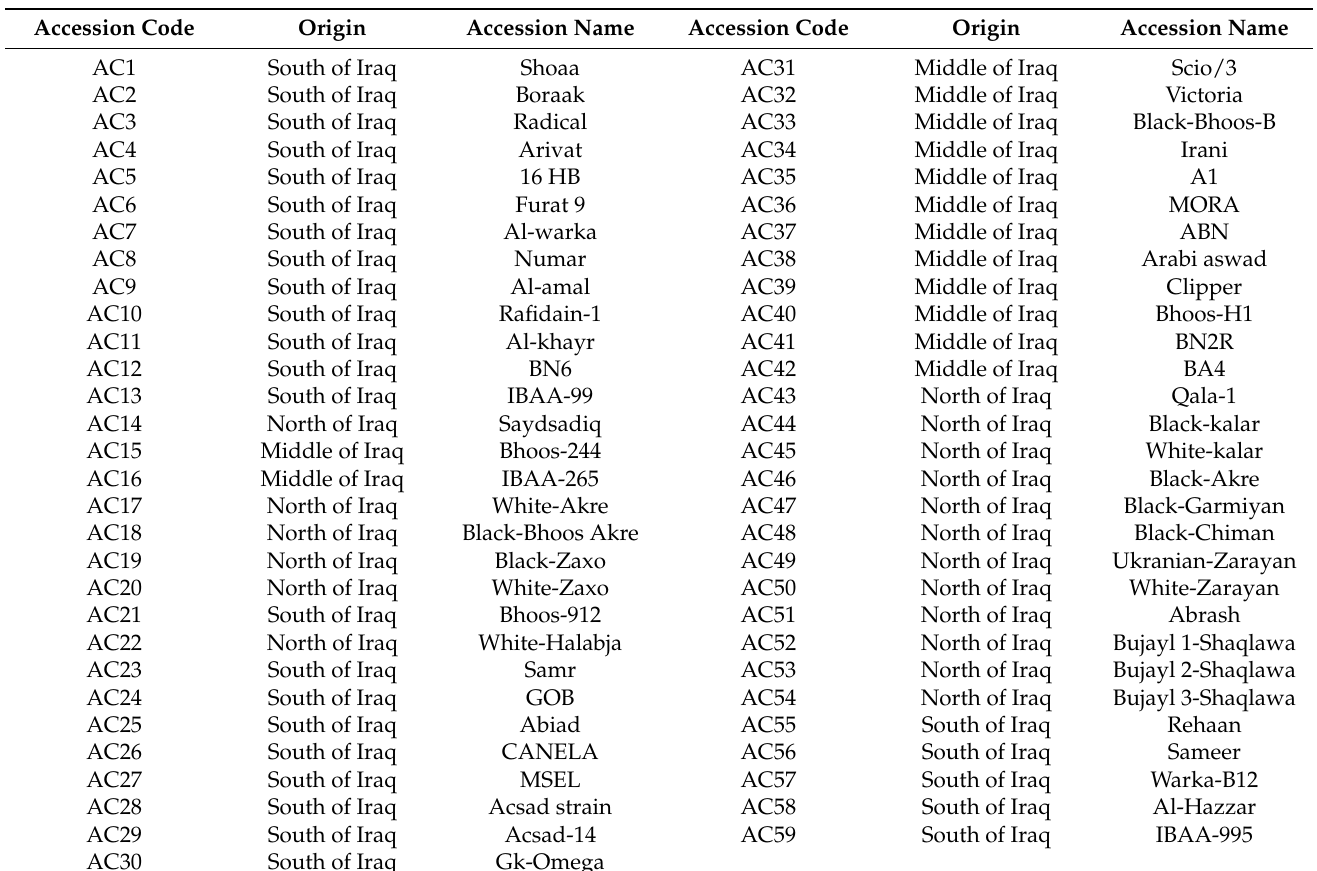
Table 1. Code, origin, and name of 59 barley accessions included in this